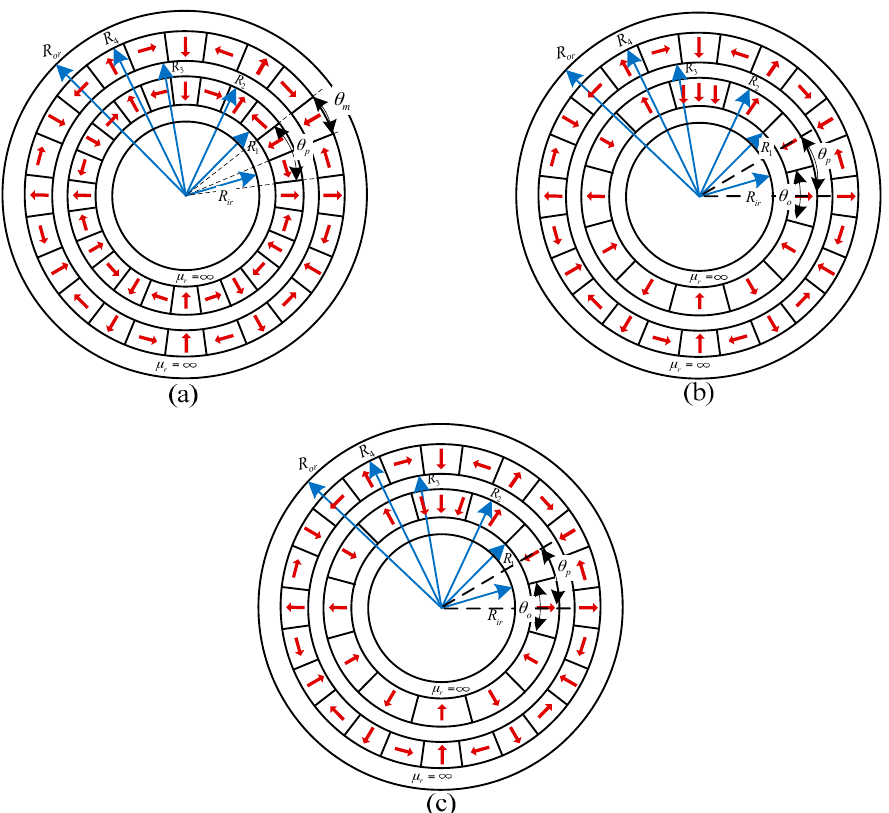
Figure 3. Structure of three common HPMCs. ( a ) Type-1 (Halbach magnetized inner rotor). ( b ) Type-2 (parallel magnetized inner rotor). ( c ) Type-3 (radial magnetized inner rotor). Table 1. Geometrical parameters of the tail conical space and the initially designed C-HPMC.